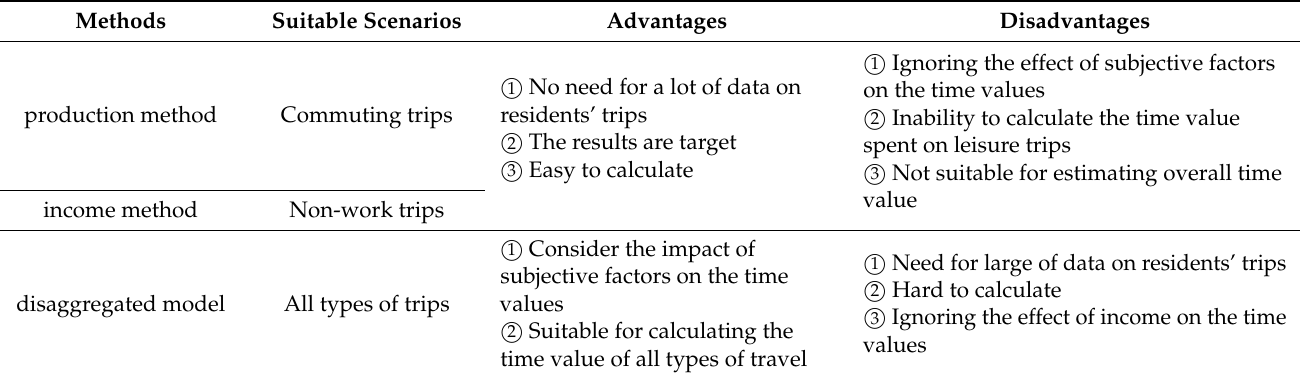
Table 1. Comparisons of three popular time value calculation